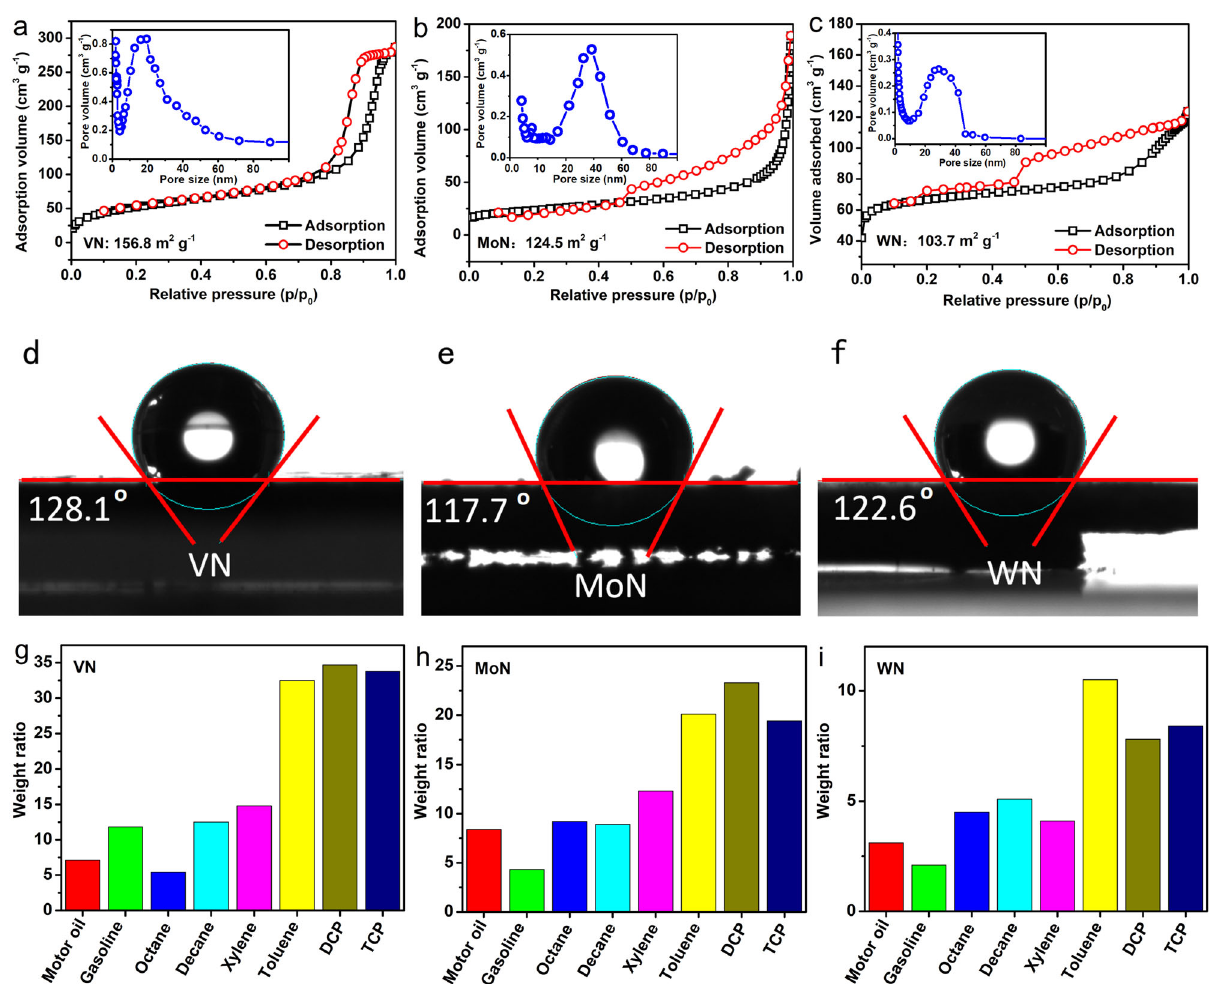
Fig. 4 Surface area, hydrophobicity, and adsorbability of the 3D porous TMNs. a – c N 2 adsorption and desorption isotherms of the 3D porous VN, MoN, and WN. d – f Surface hydrophobicity of the 3D porous VN, MoN, and WN. g – i Excellent adsorbability of the 3D porous VN, MoN, and